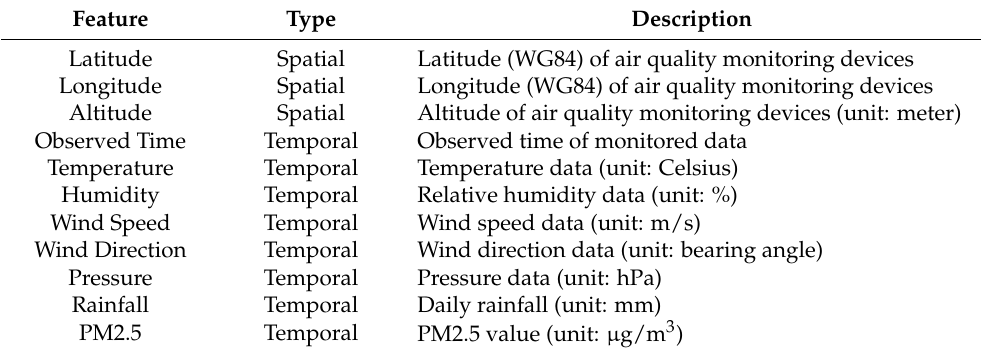
Table 1. Summary of all